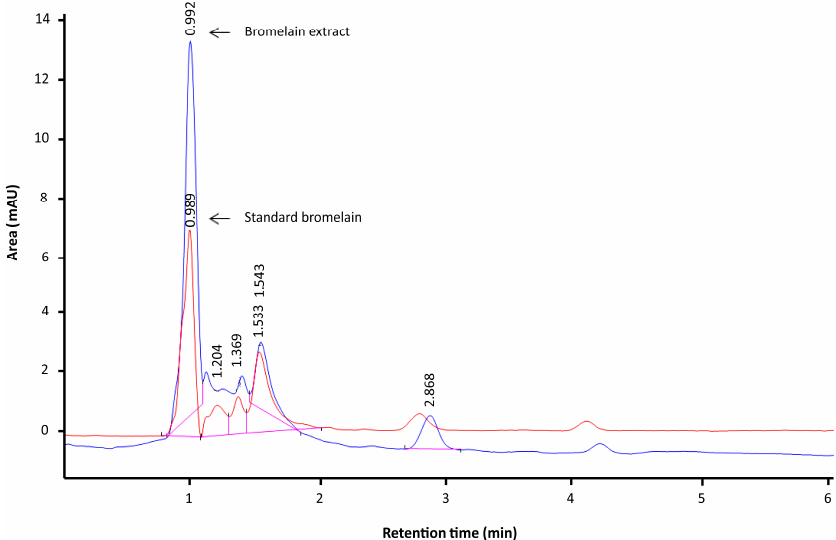
Figure 1. HPLC profile of bromelain extract (blue line) compared with standard bromelain (stem bromelain, red line). The numbers presented in the chromatograms are the retention times of the